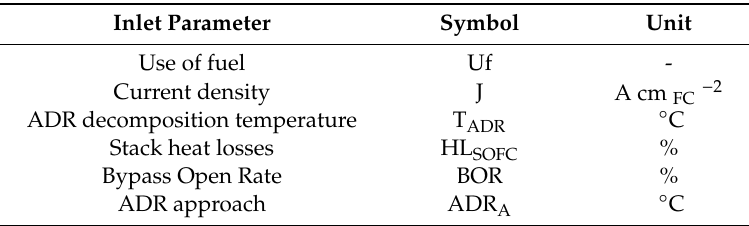
Table 4. Inputs and outputs parameters of the model.